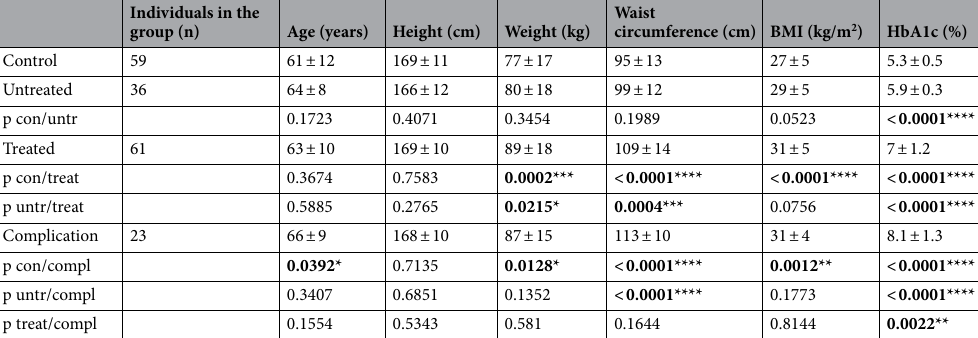
Table 1. Summary of some key data for age-matched control subjects and the three groups of T2DM patients. The values are expressed as means ± SD. The p values were calculated by the Welch’s